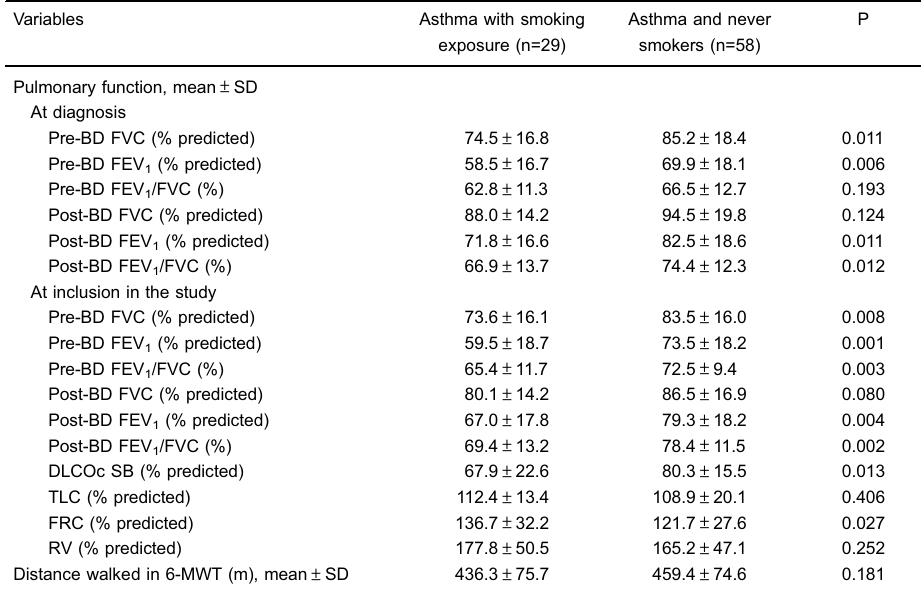
Table 3. Pulmonary function and 6-minute walk test.